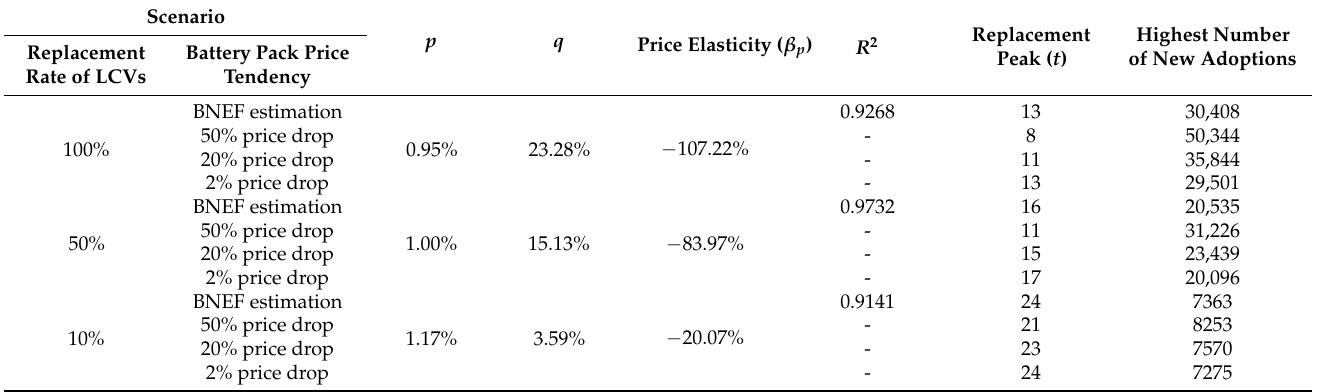
Table 5. Simulation results for the scenarios of different battery pack price